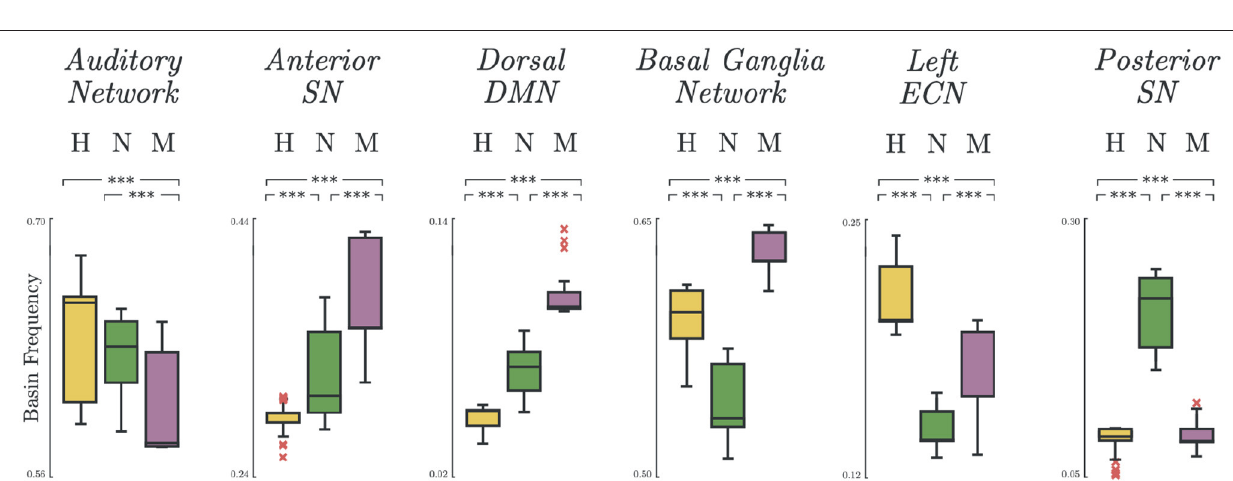
FIGURE 4 | Basin states frequency. Occurrence frequency of basins for Healthy, Non-melancholic, and Melancholic groups on various brain networks. (***) p < 0.005; between-group, pairwise comparison of basin frequencies using one-way ANOVA with Bonferroni